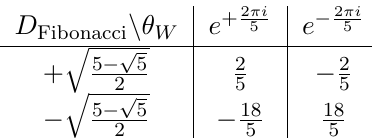
Table 2 . Central charges (mod 8 ) of the Fibonacci modular tensor category with d W = 1